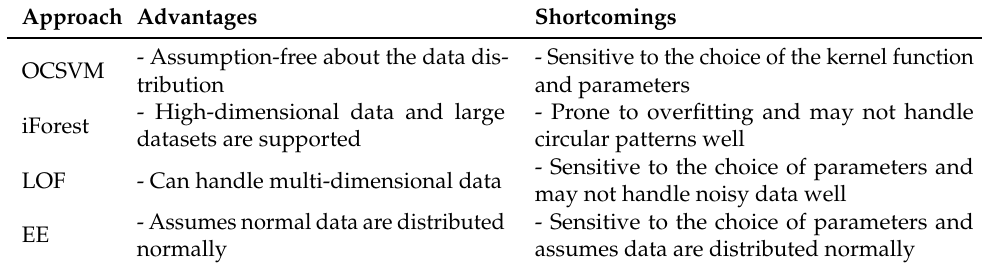
Table 2. Summary of advantages and shortcomings of four anomaly detection